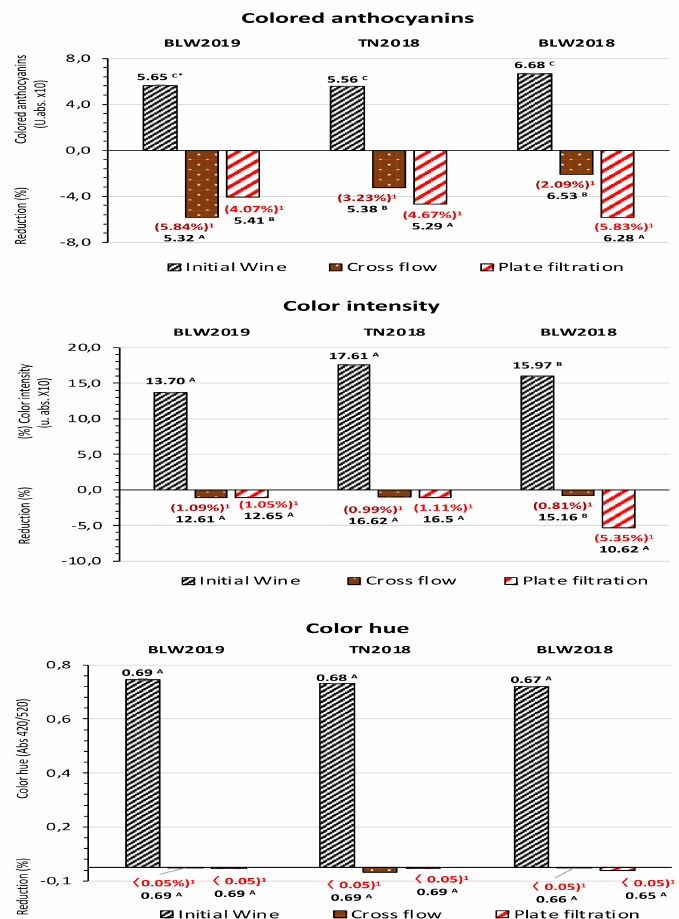
Figure 4. The impact of the two different filtration techniques on the colored anthocyanins, color intensity and color hue for the three red wines studied. TN2018, the red wine produced from the Touriga Nacional grape variety in 2018; BLW2018, the red wine produced from a blend containing Touriga Nacional, Tinta Roriz, Alfrocheiro and Jaen grape varieties in 2018; BLW2019, the red wine produced from a blend containing Baga and Tinta Pinheira grape varieties in 2019. 1 The percentage of reduction in relation to the unfiltered wine. * The average values with the same letter and for the same red wine are not significantly different (Tukey test, p <